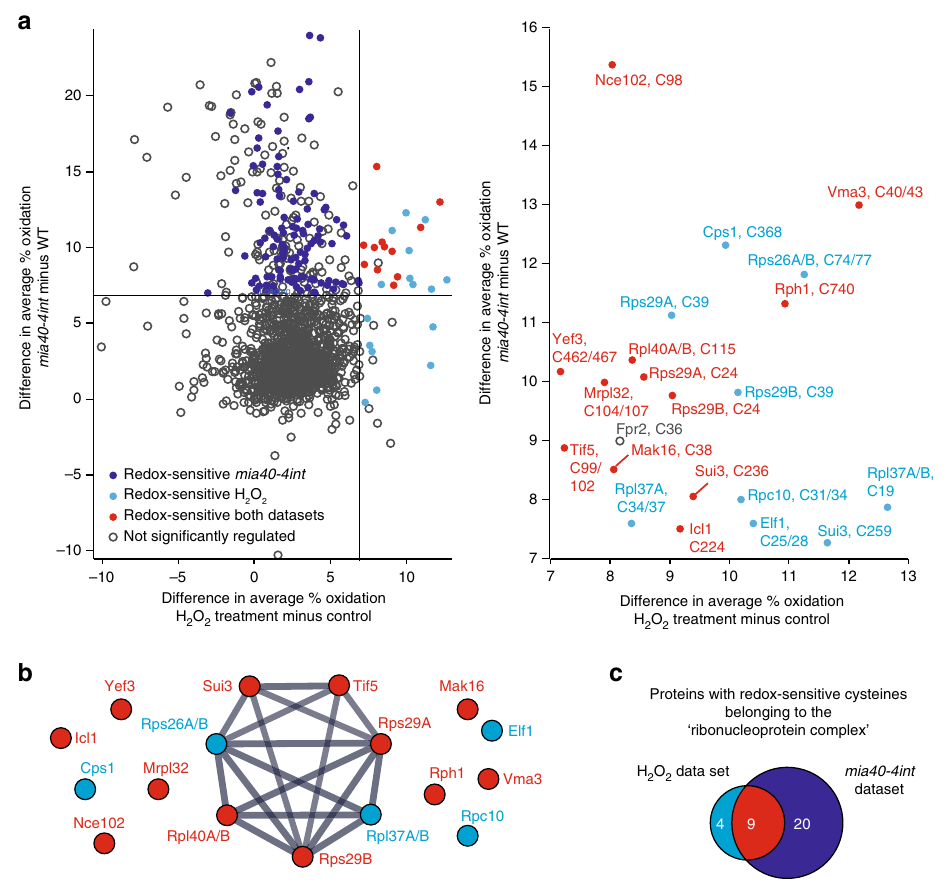
Fig. 5 Comparison between H 2 O 2 -induced and mia40-4int -dependent changes in thiol oxidation a Left: comparison of difference in average % oxidation values for 1,785 unique cysteine-containing peptides quanti fi ed in both datasets. Lines indicate difference in average % oxidation ≥ 7. Right: zoom-in of the region with an average increase in oxidation of at least + 7% in mia40-4int and upon H 2 O 2 treatment. Peptides are labelled with the respective protein names and the position(s) of cysteine residue(s) in the sequence. Unique cysteine-containing peptides that show an increase in thiol oxidation of at least + 7% with a P- value < 0.05 in mia40-4int ( n = 4) and/or upon H 2 O 2 treatment ( n = 3) are highlighted as indicated. Cysteine-containing peptides highlighted in blue in the zoom-in also exhibited increased thiol oxidation in mia40-4int ( ≥ 7%) but with P- values > 0.05 ( n = 4). b Functional protein association network of proteins which exhibited increased oxidation ( ≥ 7%) in mia40-4int and in WT yeast upon H 2 O 2 treatment using STRING 63 (version 10.0). Proteins highlighted in red showed a signi fi cant increase in thiol oxidation in mia40-4int ( P- value < 0.05, n = 4), as well as upon H 2 O 2 treatment ( P- value < 0.05, n = 3). Proteins highlighted in blue exhibited a signi fi cant increase in thiol oxidation upon H 2 O 2 treatment ( ≥ 7%, P- value < 0.05, n = 3). Thiol oxidation of these proteins was also increased in mia40-4int ( ≥ 7%) with P- values > 0.05 ( n = 4). c Comparison of the number of proteins annotated with the GO term ‘ ribonucleoprotein complex ’ with at least one unique cysteine-containing peptide with an increase in thiol oxidation of at least + 7% ( P- value < 0.05) upon H n = 3) and/or in mia40-4int ( n = 2 O 2 treatment (